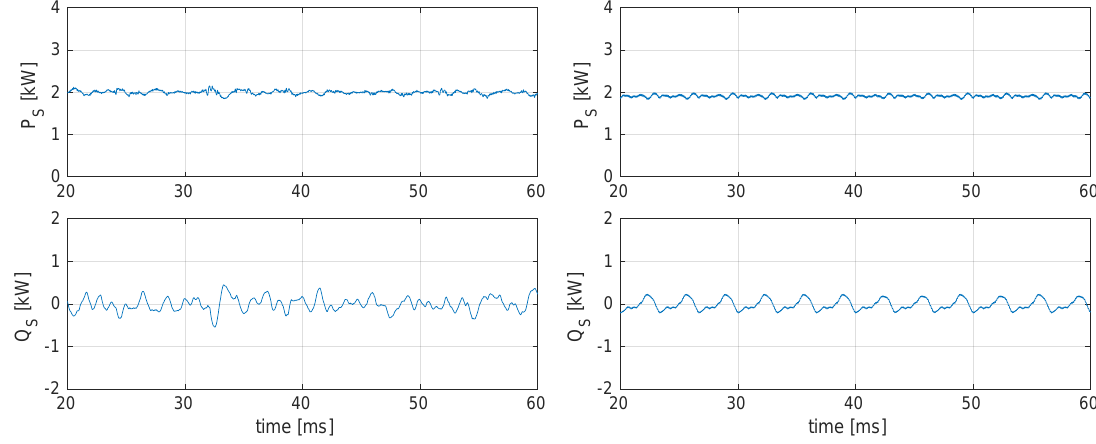
Figure 11. Simulation results of the active and reactive power at the source ( P S , Q S ). ( Left ): sigma-delta modulator. ( Right ):